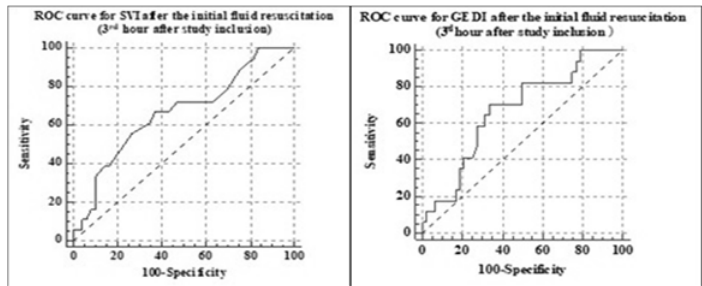
Figure 3. ROC curve analysis for the stroke volume index (SVI) and global end diastolic index (GEDI) after the initial fluid resuscitation.